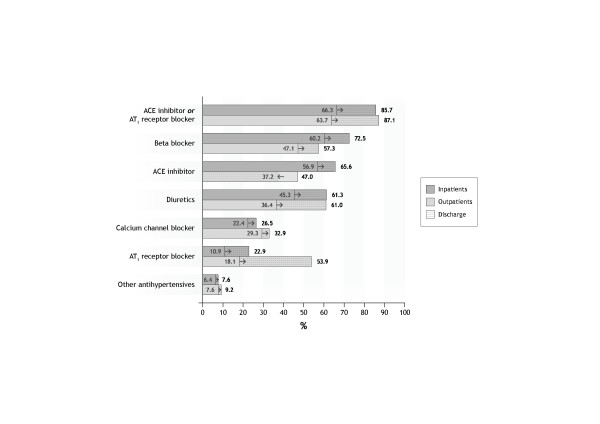
Antihypertensive medication on admission and at discharge. Figure displays the percentages of antihypertensives by class in inpatients and outpatients at admission and discharge. Arrows indicate whether the drugs are more or less frequently used at discharge. → denotes more frequently prescribed at discharge compared to admission. ← denotes less frequently prescribed at discharge compared to admission